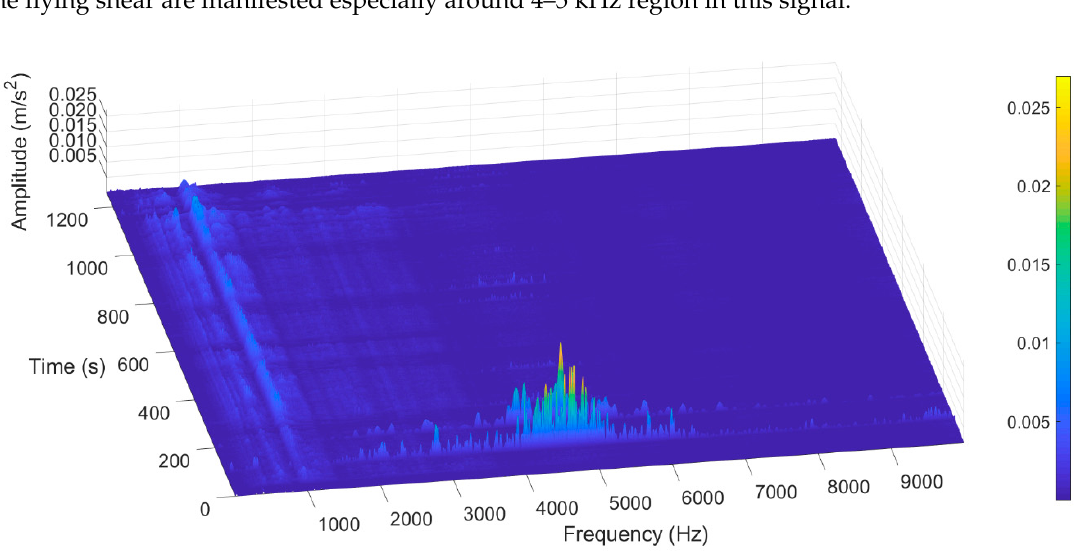
Figure 6. Amplitudes of frequency components (or bins) computed in one-second time windows during one leveling event.